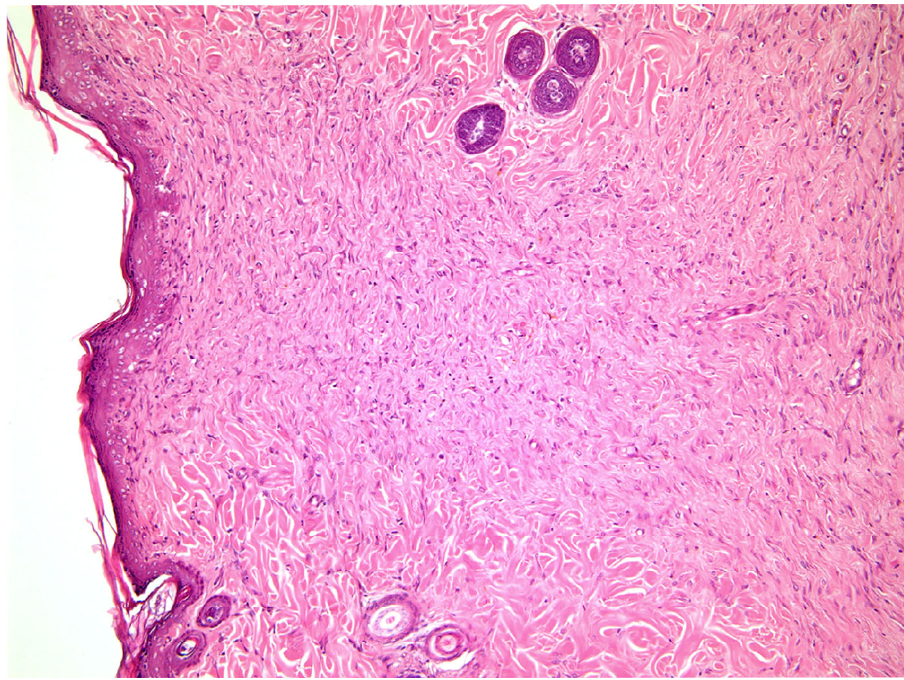
Figure A8. Histology of the wound treated with NO ‐ CGF at post ‐ operative day 21, hematoxylin and eosin staining, magnification—10×.